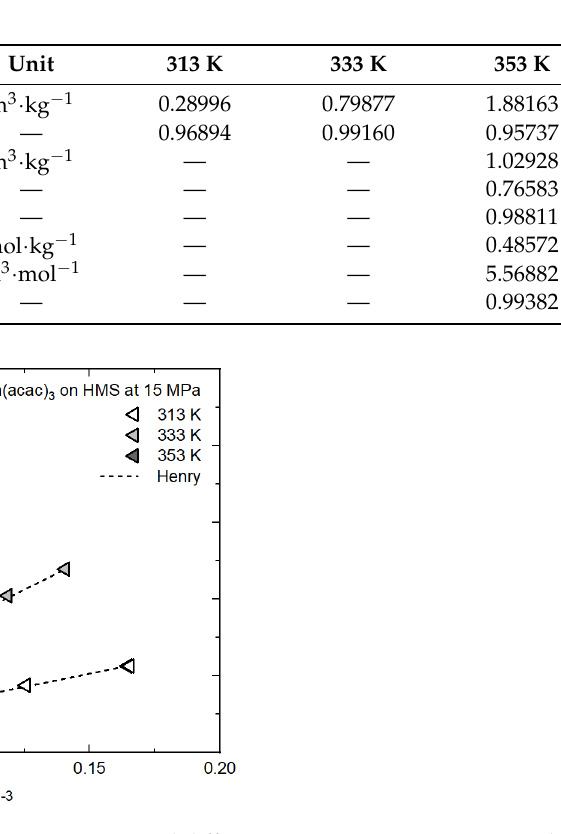
Figure A7. Uptake of Rh(acac) 3 on HMS at 15 MPa and different temperatures; experimental data taken from [62]. Table A7. Adsorption isotherm parameters for Rh(acac) 3 from scCO 2 solution on HMS at 15 MPa and different temperatures [62].